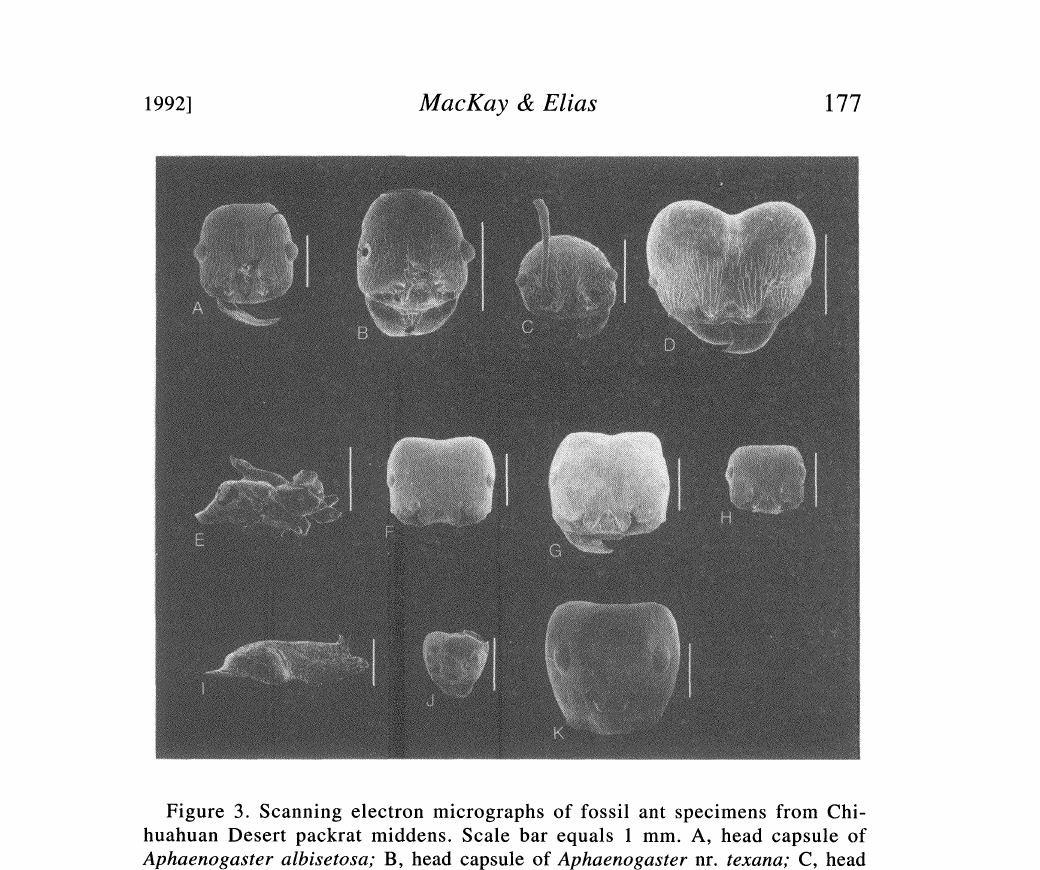
Figure 3. Scanning electron micrographs of fossil ant specimens from Chi- huahuan Desert packrat middens. Scale bar equals mm. A, head capsule of Aphaenogaster albisetosa; B, head capsule of Aphaenogaster nr. texana; C, head capsule of Aphaenogaster huachucana; D, head capsule of Pheidole subdentata; E, thorax of P. subdentata; F, head capsule of Pogonomyrmex apache; G, head cap- sule of Pogonomyrmex barbatus; H, head capsule of Pogonomyrmex species WPM- 1; I, thorax of P. species WPM-1; J, head capsule of Liometopum luctuosum; K, head capsule of Camponotus